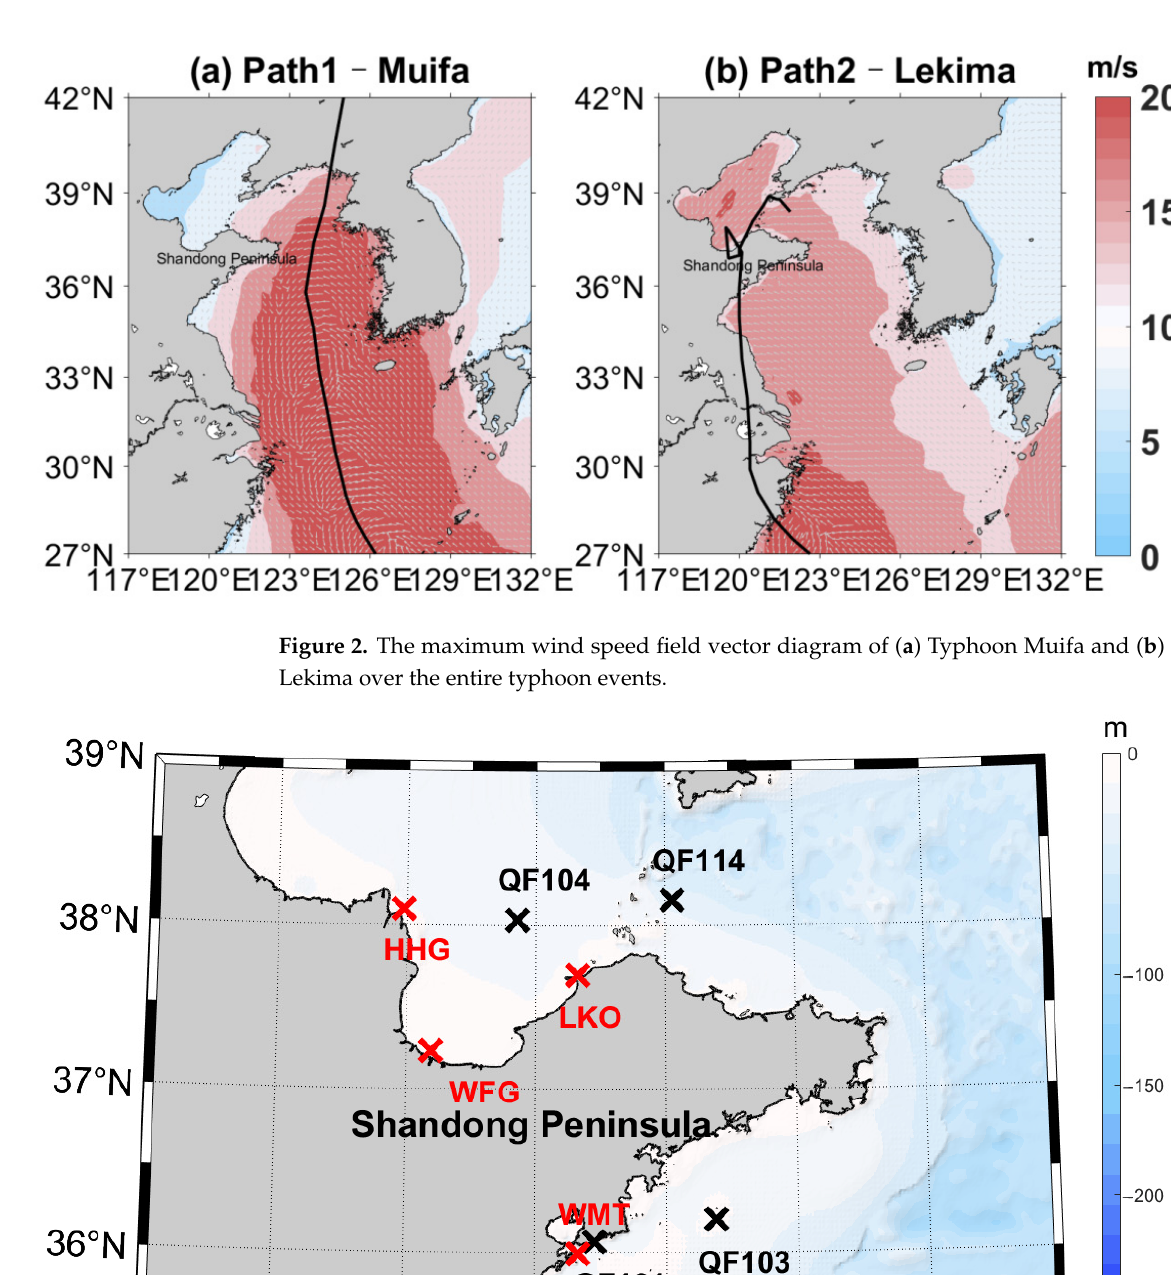
Figure 4 . Reanalyzed ERA data and observations of the wind speed of Typhoon Muifa ( a – d ) and Typhoon Lekima ( e – h ) at buoys ( a , d ) QF101, ( b , f ) QF103, ( c , g ) QF104, and ( d , h ) QF114. The red line represents observations, and the black line represents reanalyzed data from ERA5.